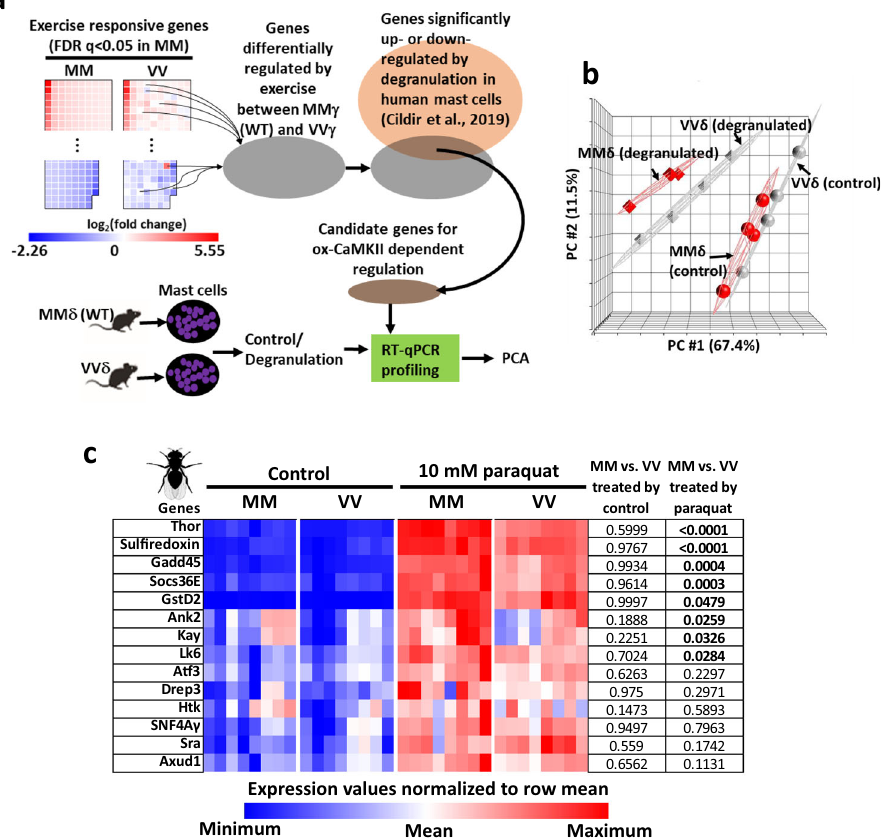
Fig. 4 The MM modules of CaMKII γ and CaMKII δ in mice and of Drosophila melanogaster CaMKII couple ROS to gene expression. a Scheme for identifying candidate ox-CaMKII-regulated genes from exercising skeletal muscle for testing in mast cells. b Principal component analysis of expression pro fi les of genes in wild-type (MM δ ) and VV δ mast cells. The mast cells were sensitized with ovalbumin (OVA)-speci fi c IgE for overnight and then treated by vehicle (control) or OVA and harvested 4 h later for RT-qPCR analysis ( n = 4 per condition). c Expression of a subset of paraquat responsive genes was quanti fi ed by RT-qPCR after RNA was extracted from fl ies ingesting control food (Control, 5% sucrose solution) or paraquat (10 mM of paraquat in 5% sucrose solution) for 24 h at 25 °C ( n = 8 biological replicates per group, each containing 15 males and 15 females). All of these genes were signi fi cantly upregulated by paraquat ( P < 0.05, two-way ANOVA). No genes showed signi fi cant differences between MM and VV fl ies fed control food, whereas a subset of genes had signi fi cantly higher expression in MM than in VV fl ies after exposure to paraquat ( P values shown in the table. Sidak ’ s multiple comparisons test, two-tailed). Source data are provided in the Source Data fi